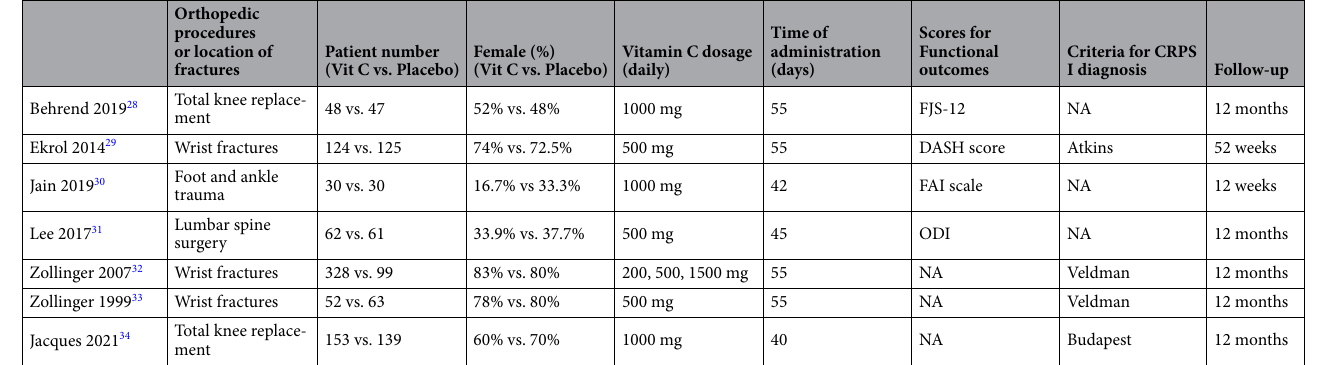
Table. 1. Characteristics of included studies (n = 7). Vit. C: vitamin C; CRPS: complex regional pain syndrome; NA: not available; FJS-12: Forgotten Joint Score-12; DASH score: The Disabilities of the Arm, Shoulder and Hand Score; FAI scale: Foot and ankle outcome instrument scale; ODI: Oswestry Disability index.